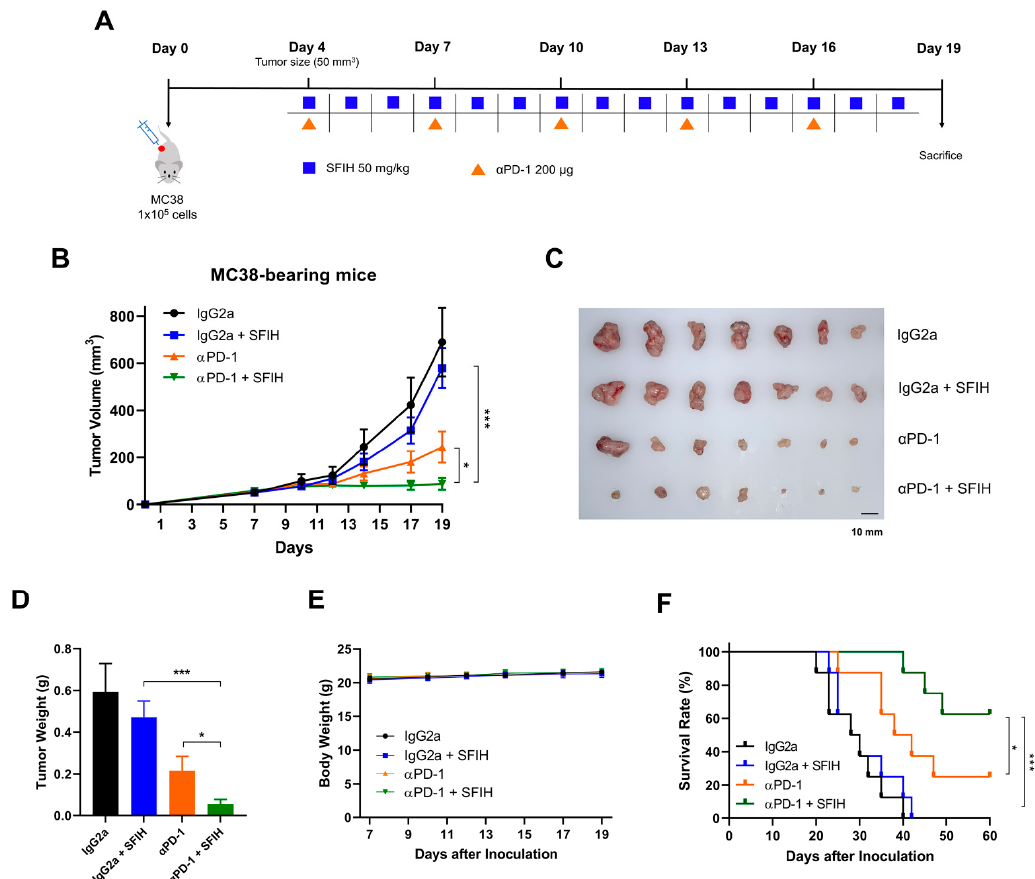
Figure 3. SFIH enhances the antitumor effect of anti-PD-1 antibody in MC38 colorectal tumor. ( A ) Schematic diagram of SFIH and anti-PD-1 antibody treatment. A total of 1 × 10 5 MC38 cells were subcutaneously injected into C57BL/6 mice. When the tumor volume reached >50 mm 3 , the mice were divided into four groups ( n = 7/group) as follows: IgG2a, IgG2a with SFIH, α PD-1, and α PD-1 with SFIH. SFIH (50 mg/kg) was intraperitoneally administered daily. Anti-PD-1 antibody (200 μ g) was intraperitoneally administered every 3 days. ( B ) Tumor volume changes in MC38-bearing mice. Tumor growth was monitored every 2 or 3 days by measuring tumor volume. Error bars represent SEM. ( C ) MC38 tumors were separated and photographed. ( D ) Tumor weights are shown. Error bars represent SEM. ( E ) Body weight changes of MC38-bearing mice. Error bars represent SD. ( F ) Kaplan–Meier survival distribution in the model is displayed for the mice following treatment ( n = 8/group). p -values were determined using the two-tailed Student’s t test for tumor volume and tumor weight and the Gehan–Breslow–Wilcoxon test for the survival curve (* p < 0.05 and *** p < 0.001, compared to the combination group).